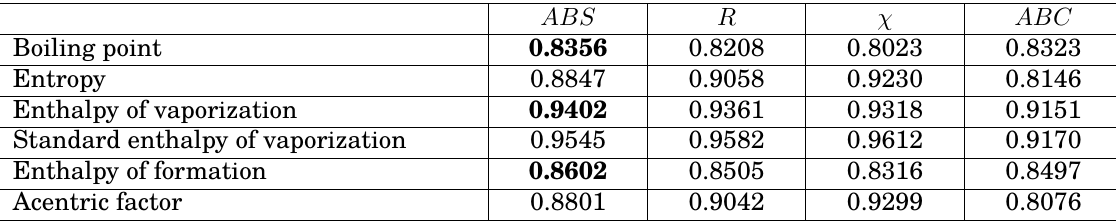
Table 2: The absolute values of the correlation coefficients between six properties of octane isomers and our indices.